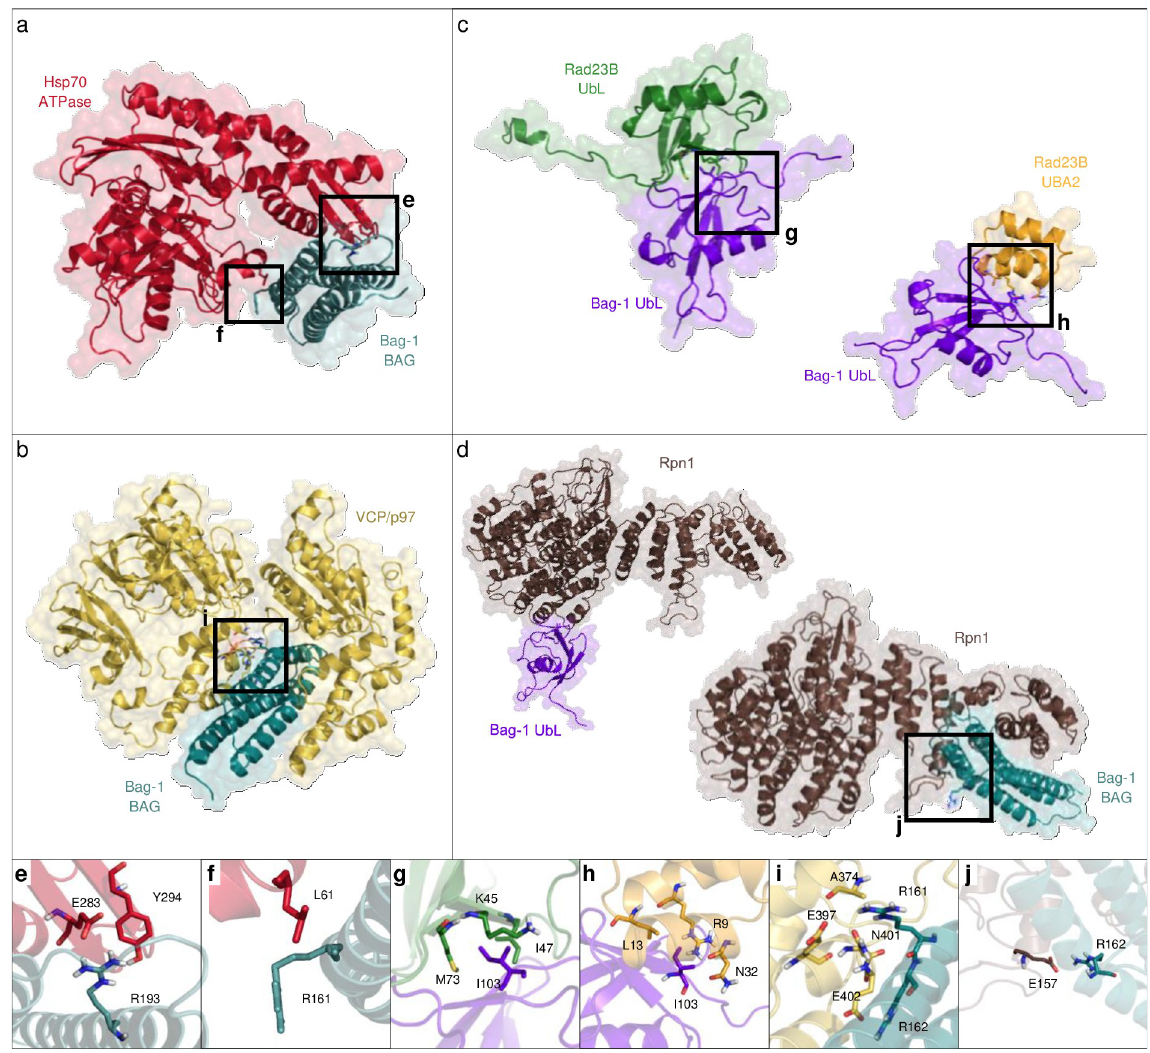
Fig 4. Structural predictions for Bag-1 complexes. Interaction of BAG domain of Bag-1 (turquoise) with a . the ATPase domain of Hsp70 (red), and b . the monomeric VCP/p97 protein (yellow). Interaction of UbL domain of Bag-1 (purple) with c . the UbL domain (green) and UBA2 domain (orange) of Rad23B. d . Interaction of BAG domain of Bag-1 (turquoise) and UbL domain of Bag-1 (purple) with the Rpn1 protein (brown). e — j . Close up views for interaction surfaces.